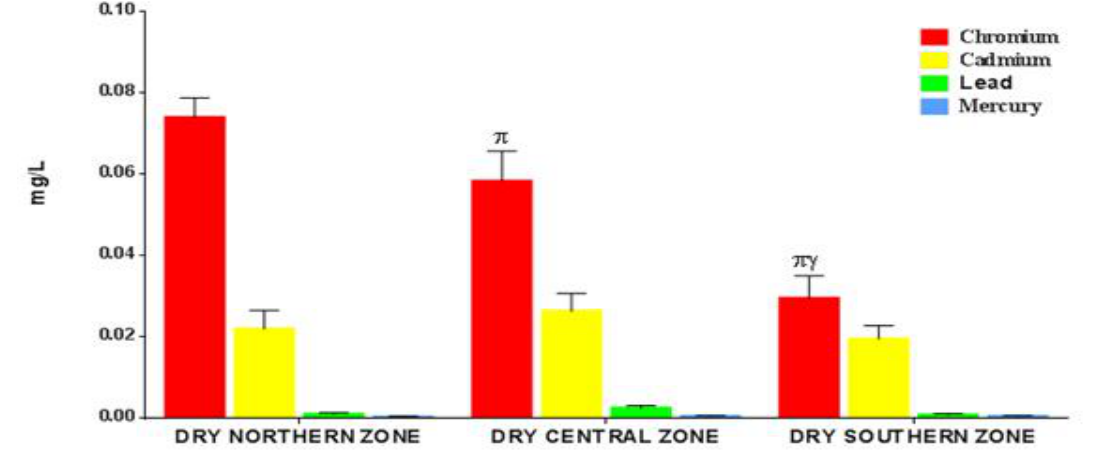
Fig. 6: Variation of mean distribution of heavy metals by geographical zones during the dry season. Data are presented as the mean ± S.E.M. p value < 0.05. Statistical analyses were performed by two-way ANOVA test, followed by Uncorrected Fisher’s LSD test for multiple comparisons (P = 0.0086 (Cr DNZ Vs Cr DCZ), P = Â 0.0001 (Cr DNZ Vs Cr DSZ), P = Â 0.0001 (Cr DCZ cal cal cal Vs Cr DSZ), P < 0.05). ð p versus dry northern zone group, ã p versus dry central zone group.